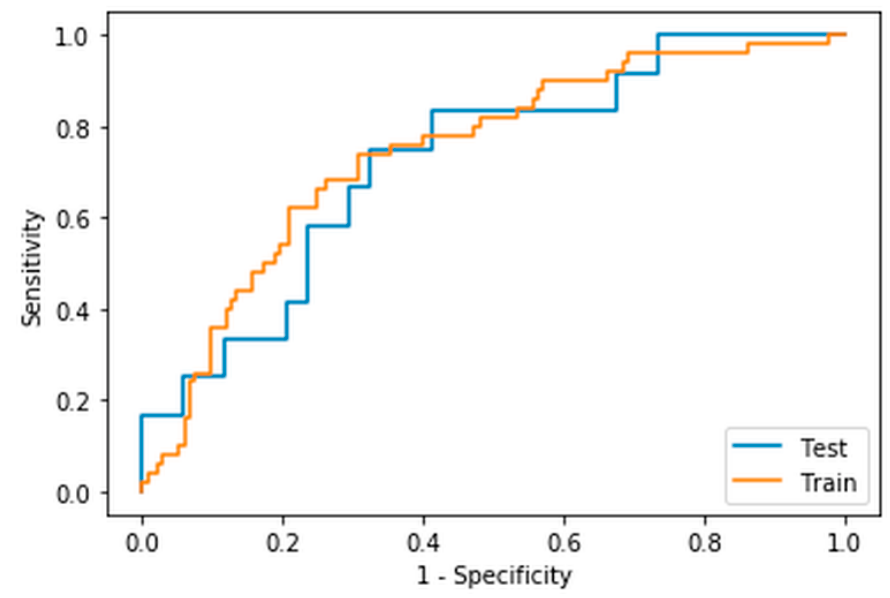
Figure 2. ROC Curve of the training and unseen test data AUCs for the model derived using a 4.0 SUV thresholding segmentation technique with a bin width derived from SUVmax/64. Table 5. The features selected and their associated coefficients and intercept in the ridge regression model tested on the unseen test dataset.